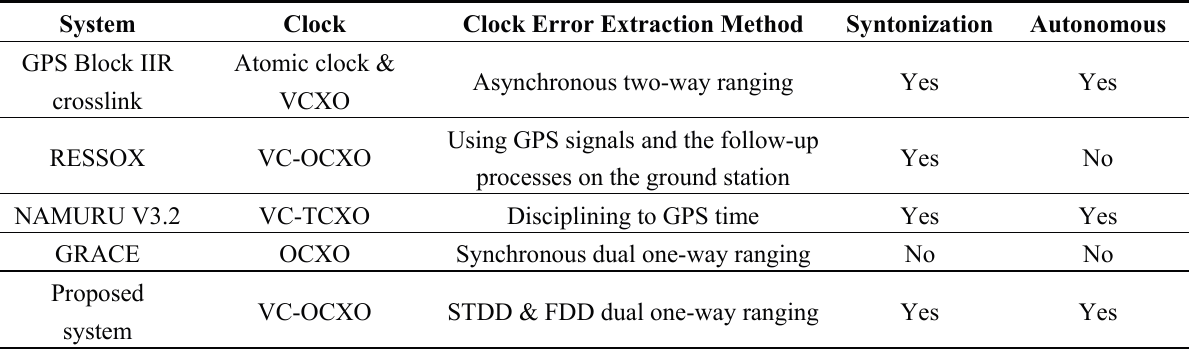
Table 1. Comparison of synchronization